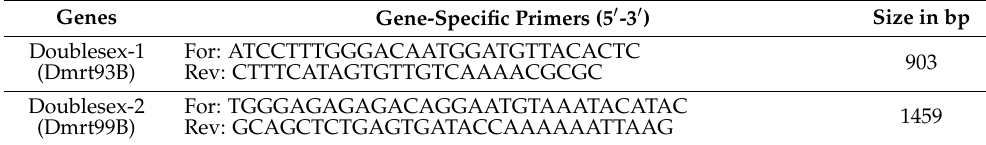
Table 1. PCR primers used to confirm the Dsx/Dmrt transcripts of A. franciscana .